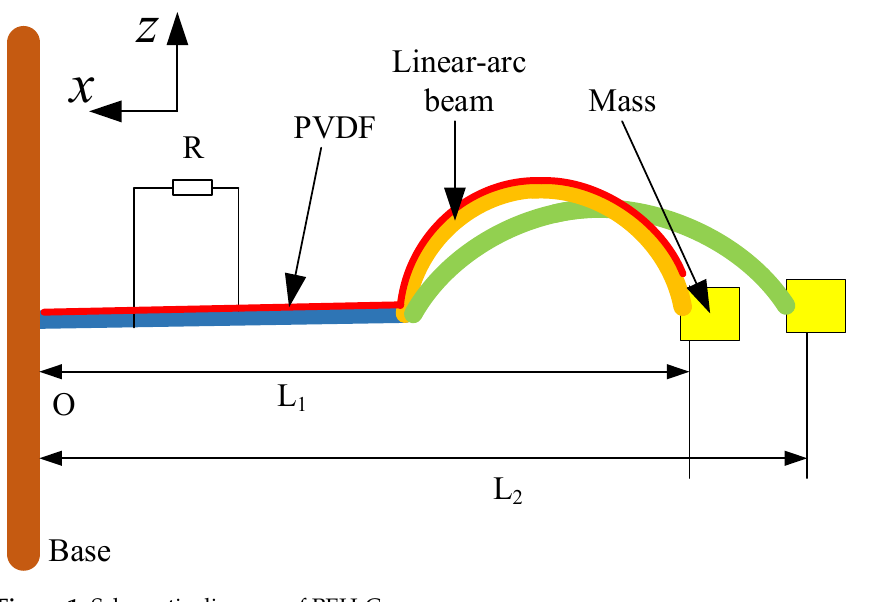
Figure 1. Schematic diagram of PEH-C.